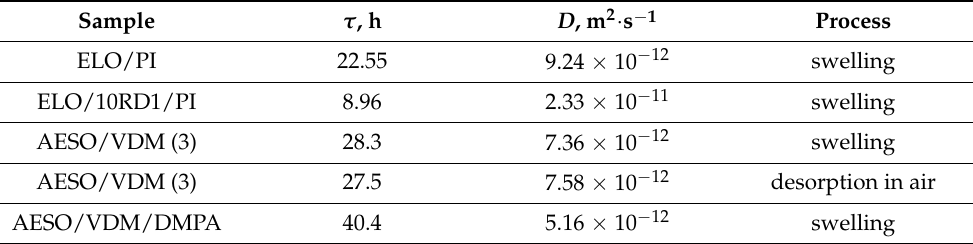
Table 3. The Estimated Diffusion Constant D and Mean First Passage Time τ for Water in the Investigated Polymer Samples at Room Temperature (23 ◦